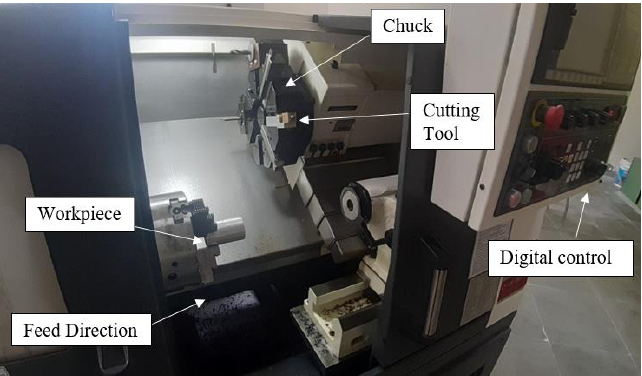
Figure 8. A complete view of SIEMENS CNC along with Tungsten Carbide Insert.